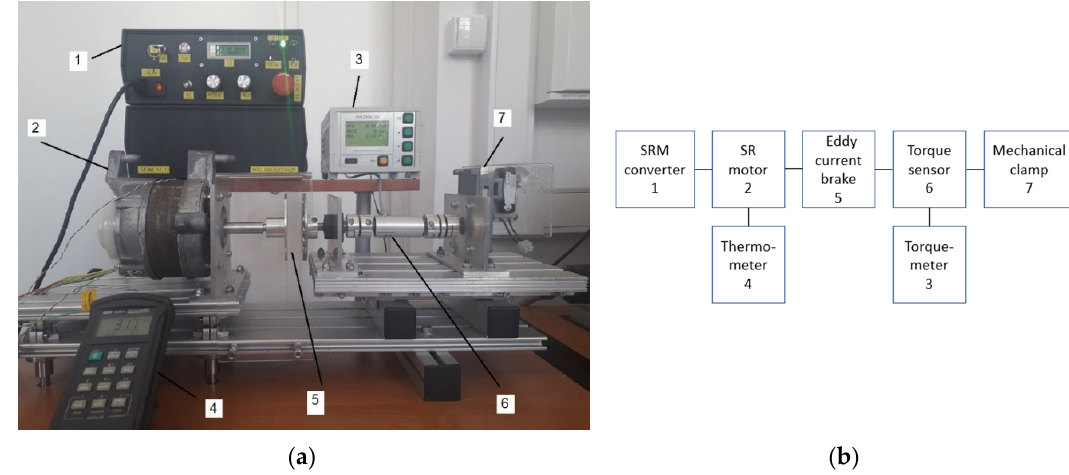
Figure 4. ( a ) Measuring stand with the SMC prototype motor; ( b ) schematic diagram of the measuring stand.